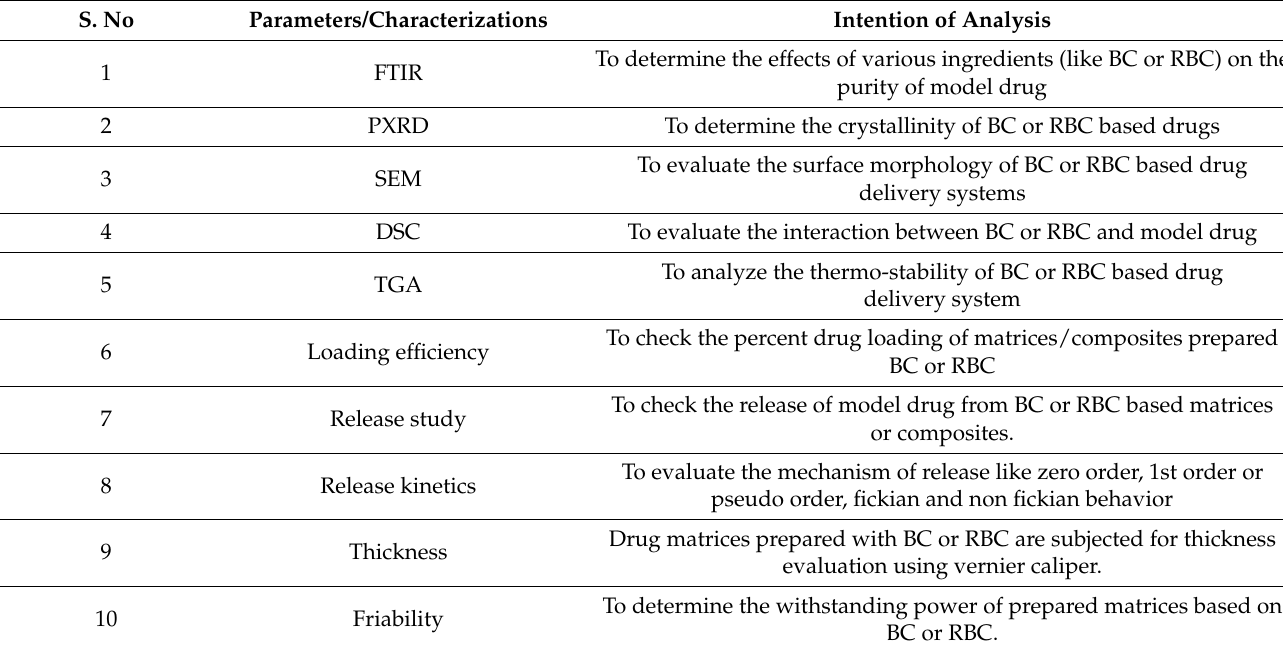
Table 2. Various characterization conducted for BC or RBC based drug delivery